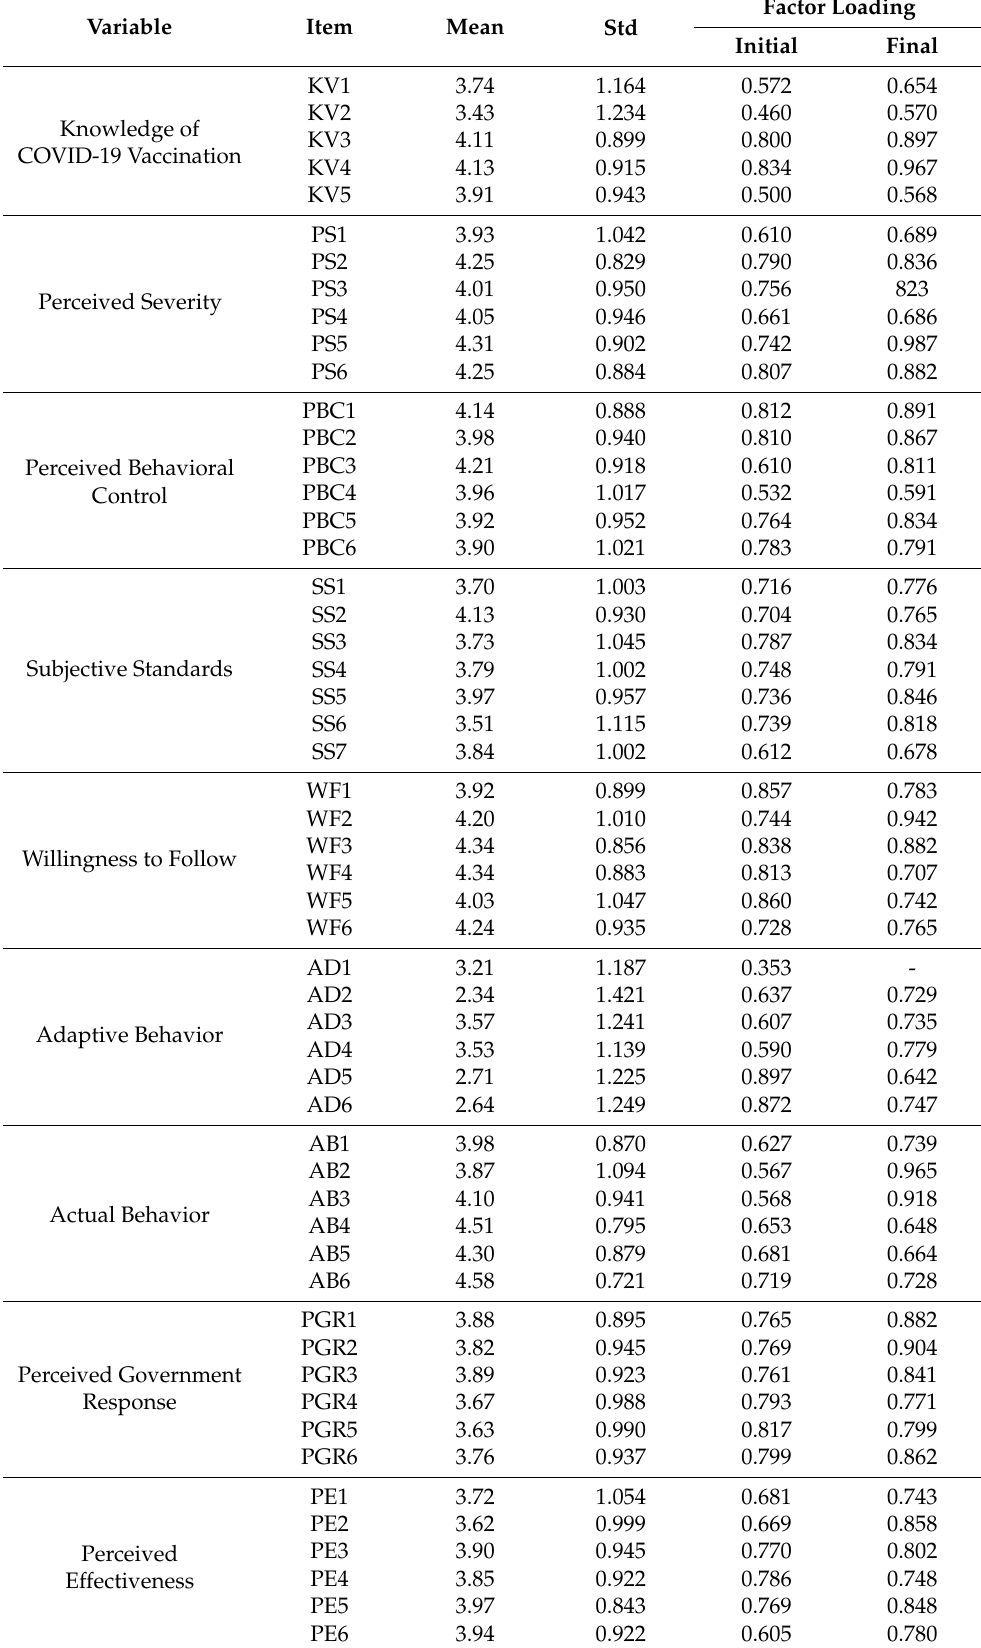
Table 3. Descriptive statistics